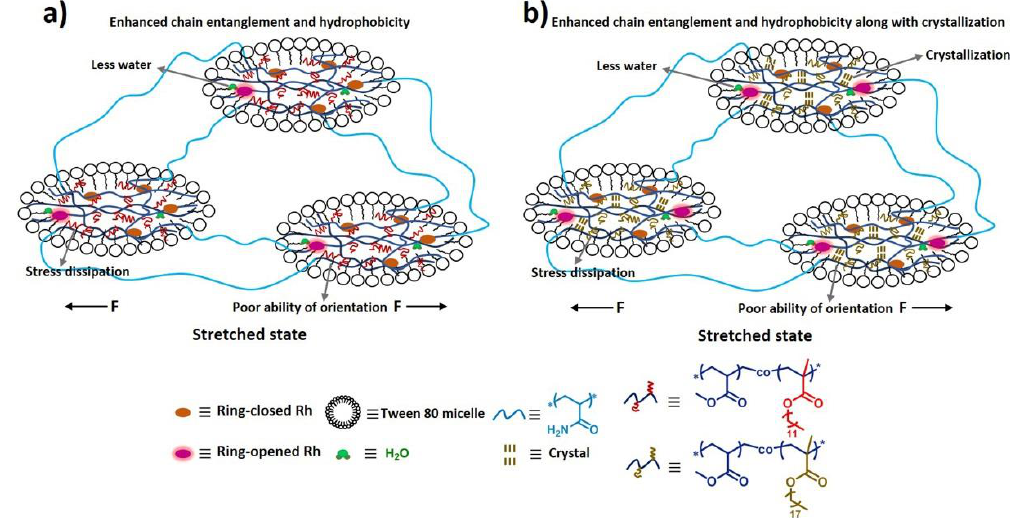
Figure 8. The microstructures of the ( a ) poly(AAm-co-MA-co-C12/Rh) hydrogel and ( b ) partially crystalline poly(AAm-co-MA-co-C18/Rh) hydrogel upon stretching (both of the hydrogels exhibited enhanced chain entanglement and